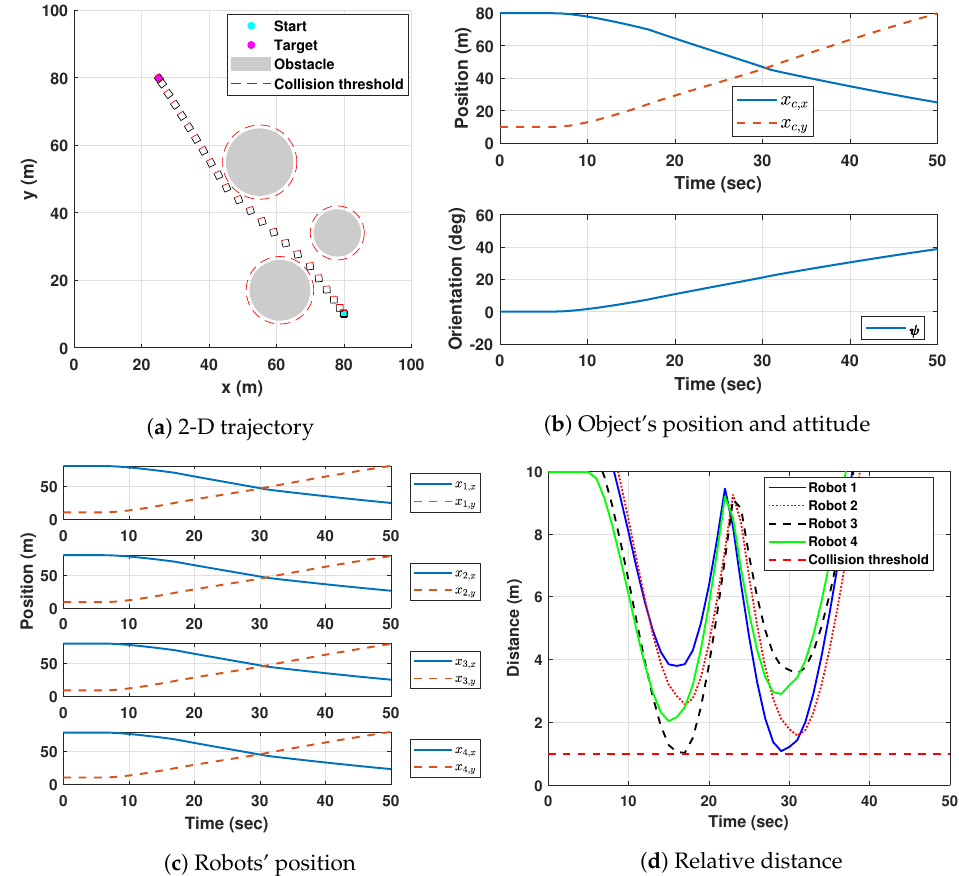
Figure 8. Optimization results: Scenario